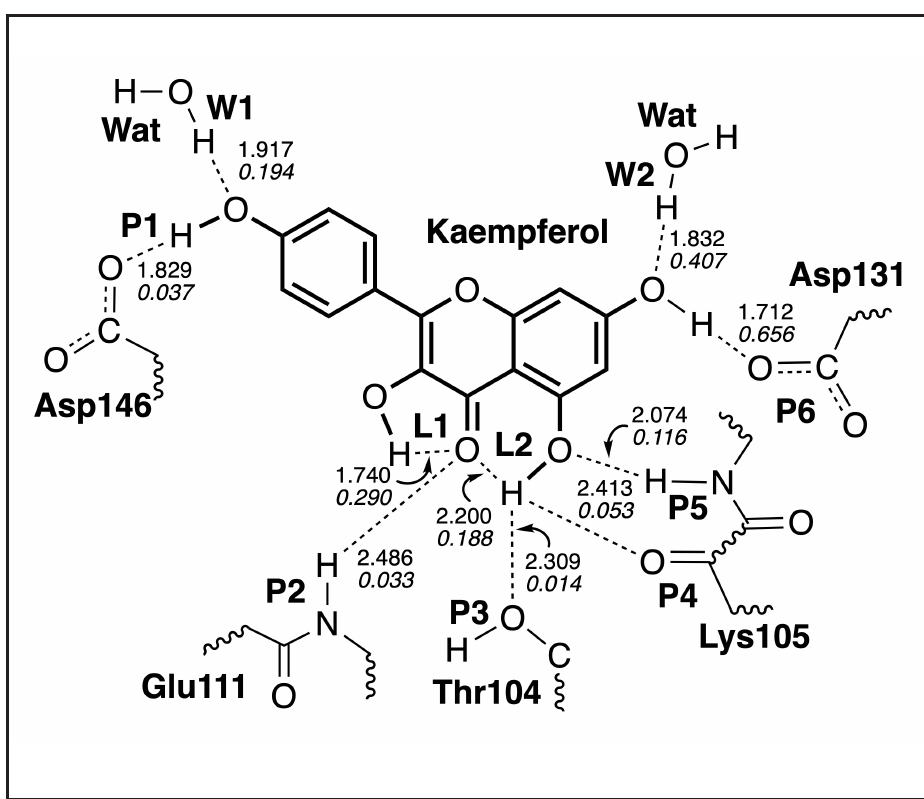
Figure 11. Hydrogen bonds in the Kaempferol-NS5 complex (dashed lines). Bond lengths are shown in the normal font, BSO values are shown in the italic font. ω B97X-D/6-31G(d,p)/AMBER level of theory.